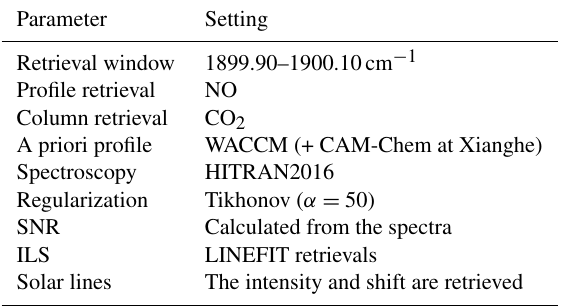
Table 1. The retrieval strategy of FTIR NO retrieval in this